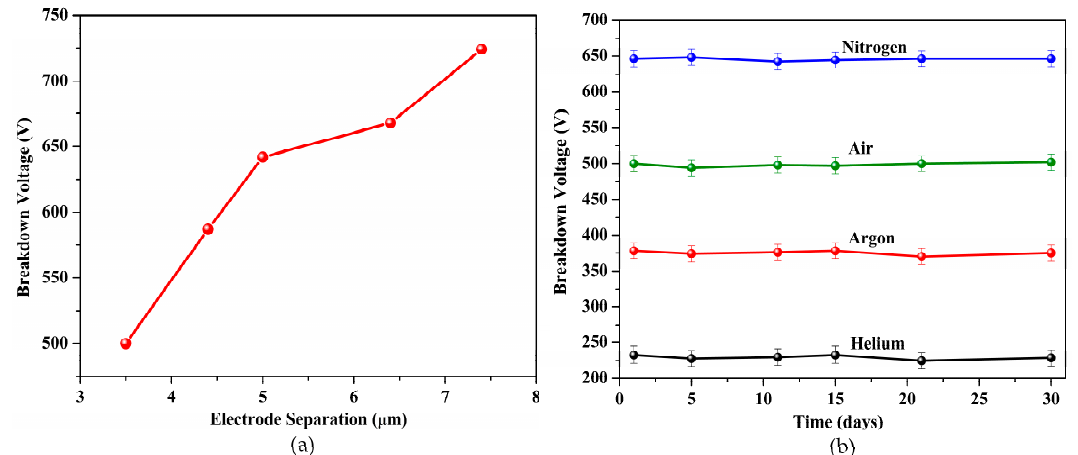
Figure 8. ( a ) Effect of inter-electrode distance on the breakdown voltage, and ( b ) Long-term stability of the sensor with tests performed at intervals of 5 days. The breakdown voltage did not vary significantly with time.